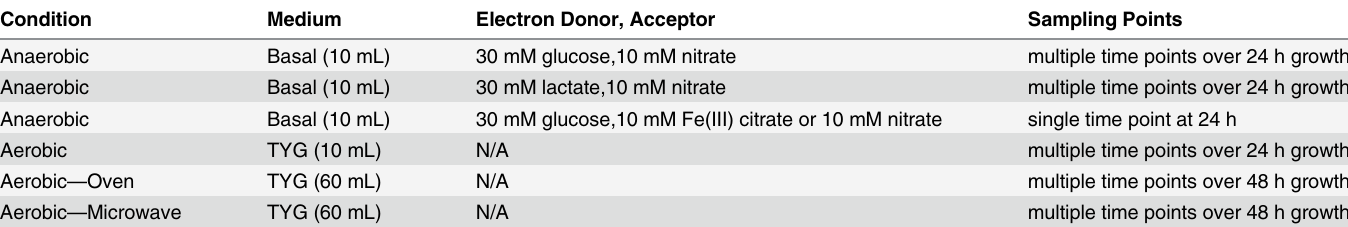
Table 1. Experimental growth conditions and time points for gene expression profiling in T . scotoductus